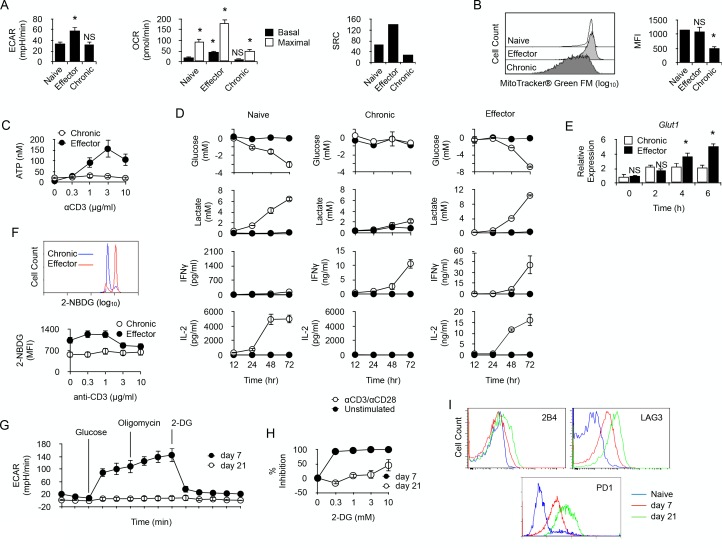
Long-term chronic anti-male CD4+T cells exhibit a low metabolism and are unable to shift their metabolism to produce IFNγ after activation.(A) Basal ECAR (left) and basal and maximal OCR (right) of naive, effector or chronic CD4+ T cells. Data (means ± SEM of five replicated cultures) are representative of two independent experiments. * indicates p=0.0079 by the Mann-Whitney test. (B) Mitochondria mass of effector or chronic CD4+ T cells labeled with MitoTracker Green FM. Means ± SEM of MFI from T cells isolated from 4 mice per group is shown. Data are representative of two independent experiments. * indicates p=0.0079 by the Mann-Whitney test. NS is non-significant. (C) ATP in effector or chronic CD4+ T cells before and after anti-CD3/CD28 antibody stimulation. Data (means ± SEM of five replicated cultures) are representative of two independent experiments. (D) Purified naive, effector or chronic CD4+ T cells were stimulated with anti-CD3/CD28 antibodies or left unstimulated. After 12, 24, 48 and 72 hr, culture supernatants were harvested and glucose, lactate, IL-2 and IFNγ concentrations were determined as described in Material and methods. Data (means ± SEM from five replicated cultures) are representative of two independent experiments. (E) GLUT1 mRNA expression was assessed by quantitative PCR in effector and chronic CD4+ T cells after activation with PMA/ionomycin. Data (mean ± SEM) are from 4 to 5 mice per group and are representative of two independent experiments. * indicates p=0.0079 by the Mann-Whitney test. (F) Flow cytometry analysis of effector or chronically stimulated (chronic) CD4+ T cells labeled with 2-NBDG ex vivo (higher panel) or following anti-CD3/CD-28 antibody stimulation (lower panel). Means ± SEM of MFI from five animals per group and are representative of three independent experiments. (G) Mitostress assay on chronic CD4+ T cells isolated 7 or 21 days isolated from non-irradiated B6 male (H-2b) Rag2-/- Il2rg-/- recipients 21 days after reconstitution with purified Marylin CD4+ TCRBV6+ T cells. Data are representative of two independent experiments. (H) 2-DG-mediated inhibition of IFNγ production by anti-CD3/CD28-stimulated chronic CD4+ T cells. Data (mean ±SEM) were calculated from five replicated cultures and are representative of two independent experiments. (I) Ex vivo expression of inhibitory receptors 2B4, LAG3 and PD-1 by naive Marilyn CD4+ T cells or chronic CD4+ T cells purified from non-irradiated B6 male (H-2b) Rag2-/- Il2rg-/- recipients 7 or 21 days after reconstitution with purified Marylin CD4+ TCRBV6+ T cells. Data are representative of two independent experiments.